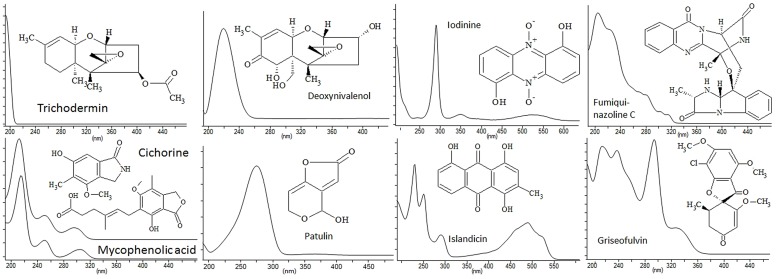
UV/Vis spectra (pH 3) and structures of some common fungal natural products illustration the diversity in absorption range depending on the number of conjugated double bonds present in the molecules.